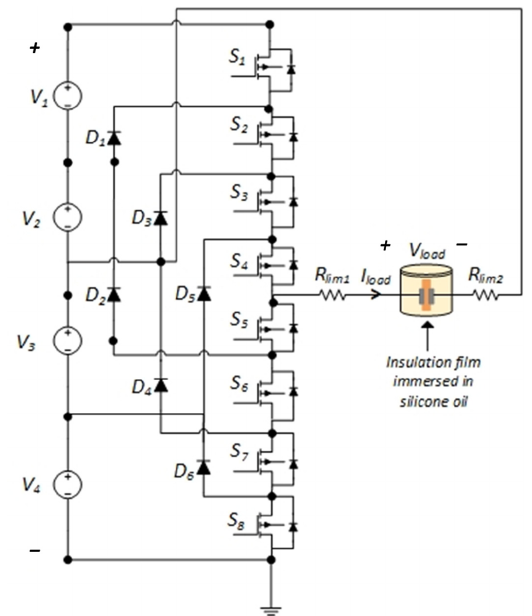
Figure 14. Schematic of a five-level NPC multilevel inverter used for experimental tests.